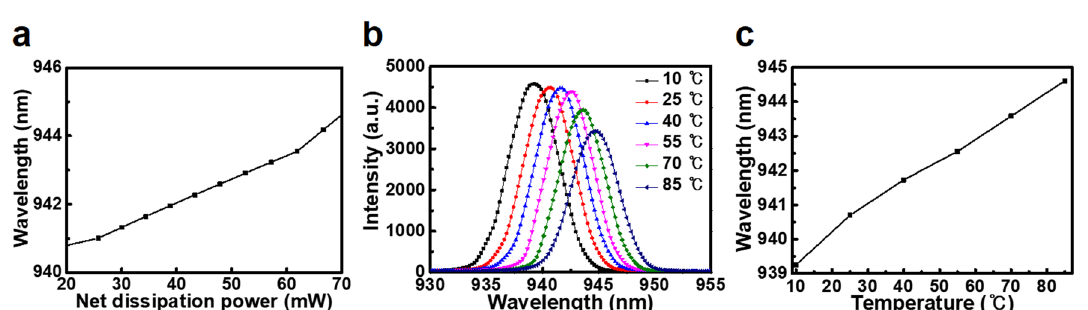
Figure 6. Thermal resistance ( R th ) of top-emitting 940-nm thin-film VCSEL. ( a ) Wavelength shift as a function of dissipated electrical input power. ( b ) Output spectrum of the thin-film VCSEL with the varied temperatures from 10 to 85 °C. ( c ) Thermal wavelength shift of the thin-film VCSEL for temperatures from 10 to 85